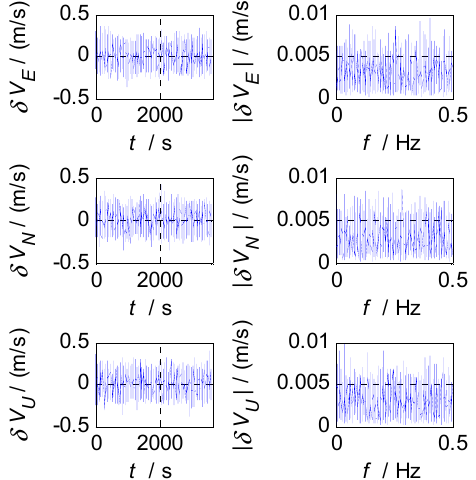
Figure 8. It can be seen that the cut-off frequencies corresponding to the minimum values of the three velocity errors are very close. Therefore, the same cut-off frequency value can be selected for Figure 5. The relationship between f c Figure 5. The relationship between 1 c f and